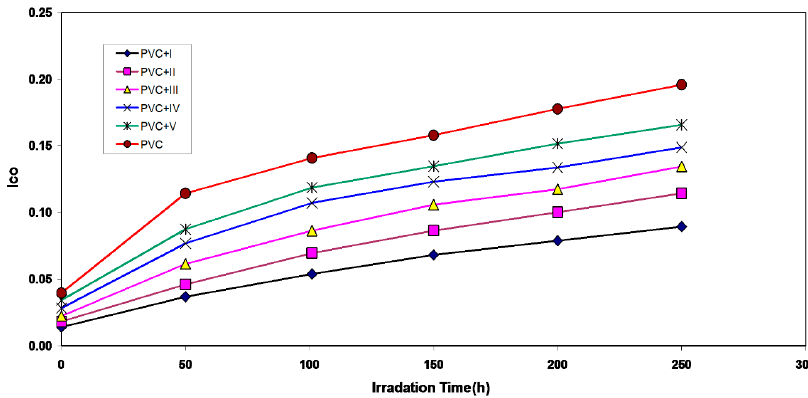
Figure 1. Change in IR spectrum of PVC film (30 µm) in the presence of the III compound (numbers in the spectra are the irradiation times in hours).